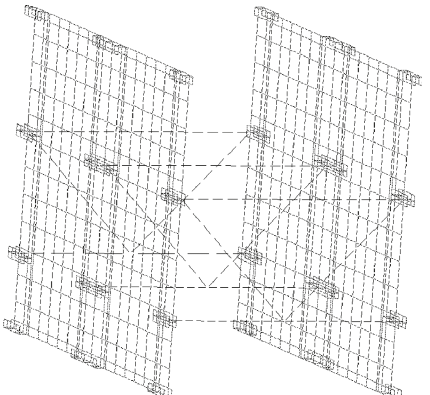
Figure 5: The whole model of the column component.